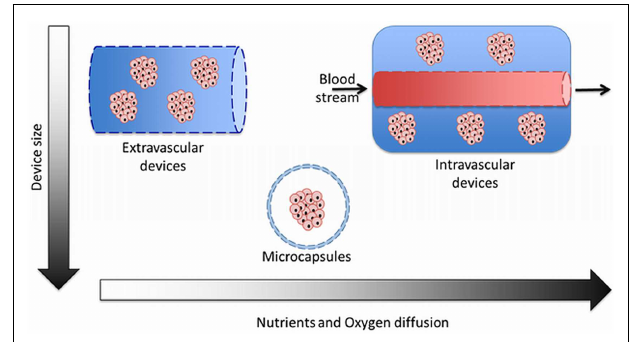
FIGURE 2 | Principle of immunoisolation by a microcapsule .The semipermeable membrane allows the diffusion of molecules such as nutrients, glucose, oxygen, and insulin while protecting the graft from the effector molecules of the immune system of the